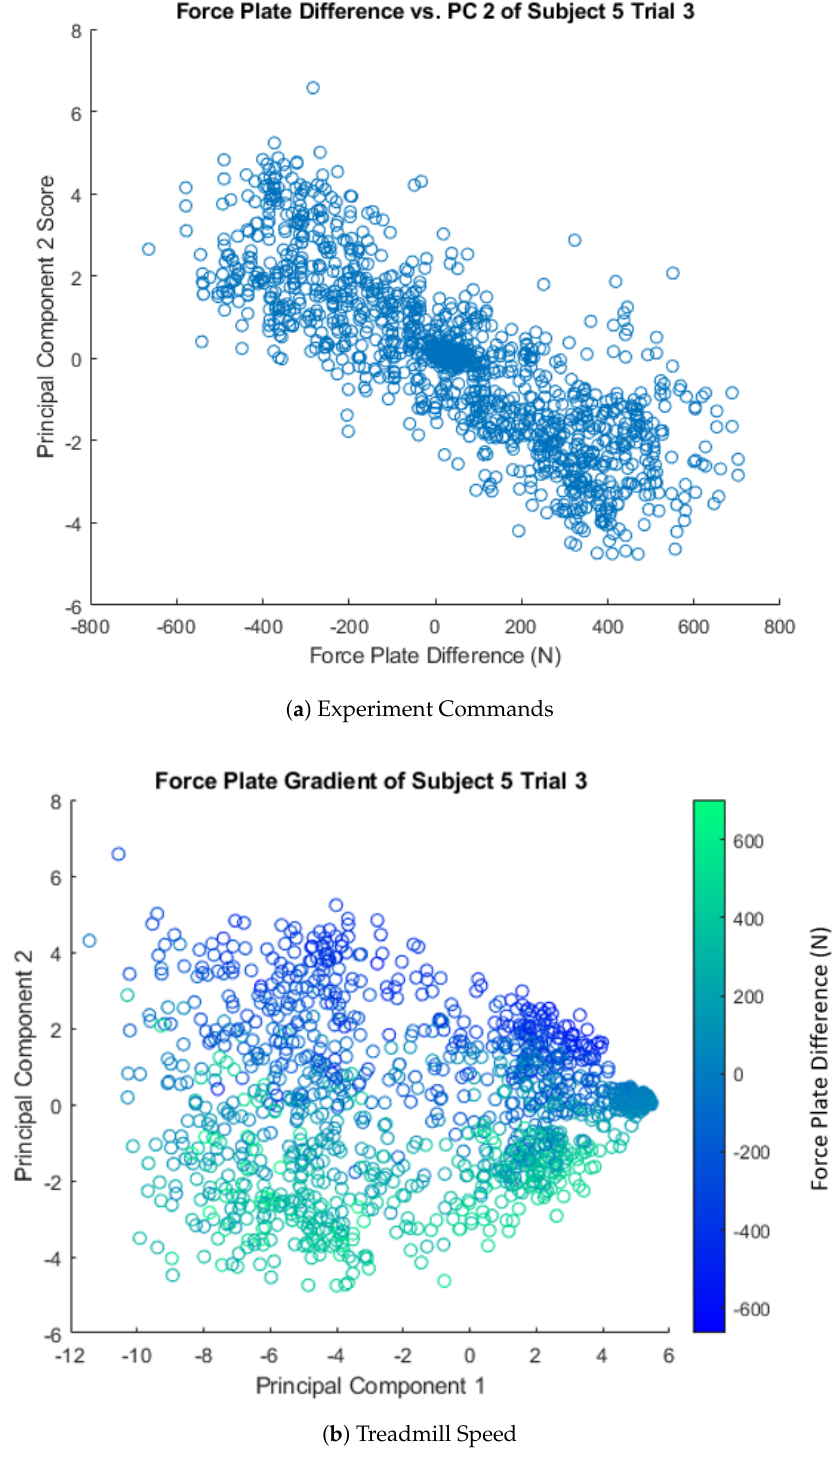
Figure 5. ( a ) A plot of the difference in force plate readings versus the scores of Principal Component 2. A high level of correlation between the two can be seen with the strong negative slope. This correlation can be seen over all trials, but Subject 5 Trial 3 was selected as a representative case. ( b ) Principal component scores plotted with a gradient representing the difference in force plate readings. When the subject places all of their weight on a single leg (single support), the difference between force plates is at the maximum absolute value. The gradient can clearly be seen along the axis of the second principal component, which indicated that this principal component is driven by the variation of right and left leg